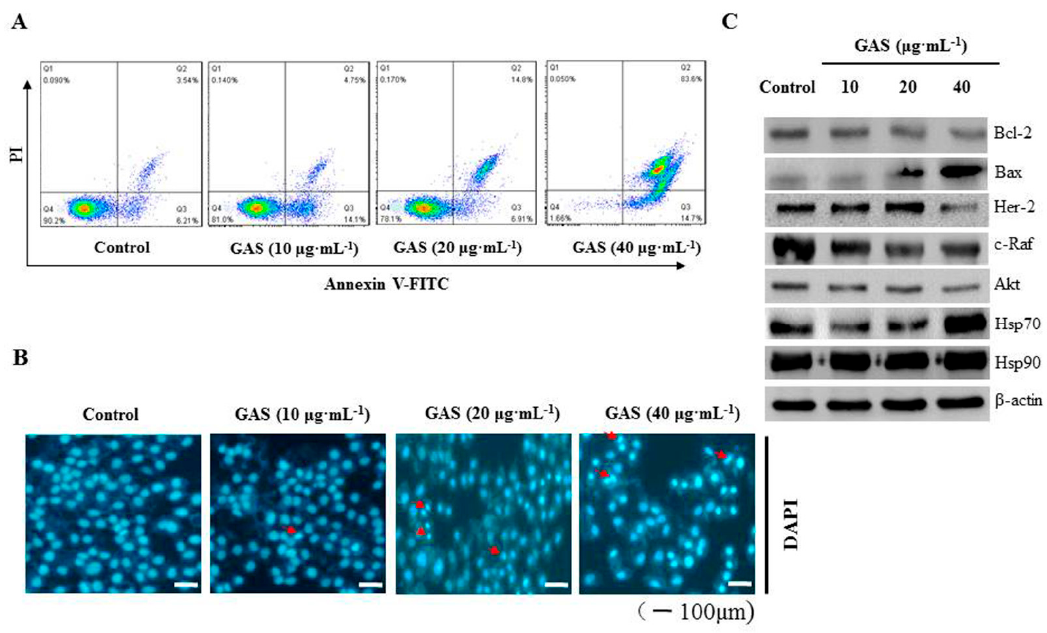
Figure 4. GAS induction of apoptosis in CNE-2Z cells. ( A ) Flow cytometric analysis of cell death after being treated with GAS using Annexin V-FITC/PI staining. ( B ) CNE-2Z cells treated with GAS for 24 h, subjected to DAPI staining, and visualized using fluorescence microscopy. Red arrowheads indicate apoptotic cells. ( C ) Western blot analyses of apoptosis-related protein levels in CNE-2Z cells. β -actin was used as an internal control.